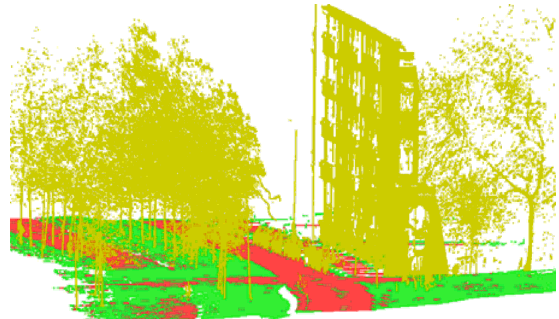
Figure 2. Ground point classification. Red, green and brown colours denote the road, terrain and objects points